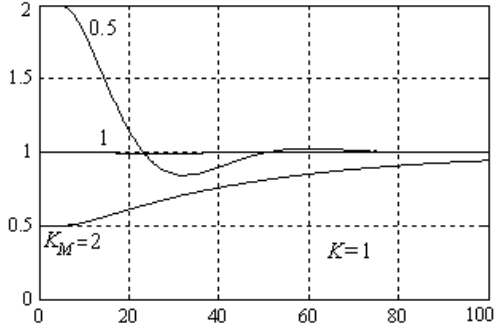
Figure 6. Control responses c ( t ) to a unit step setpoint for τ M = 5, T sM = 53 and various K M .